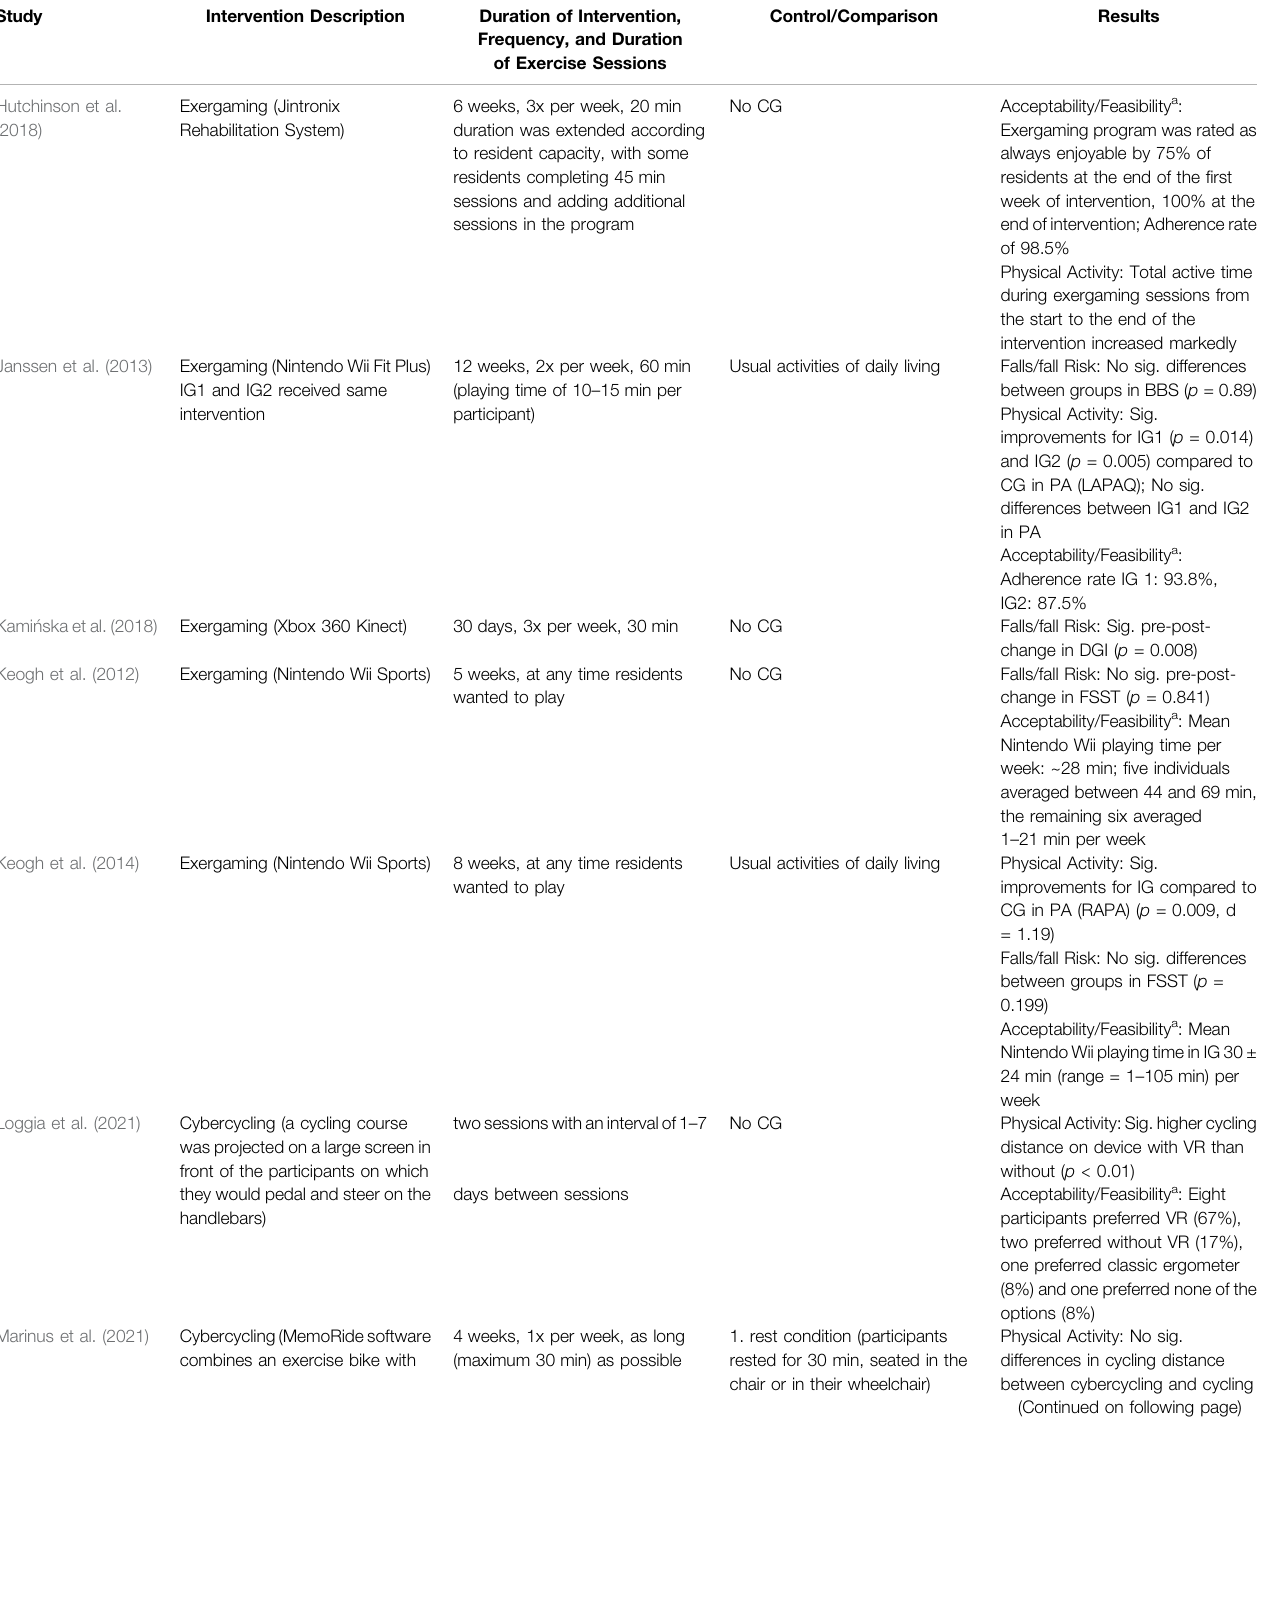
TABLE 3 | ( Continued ) Intervention/control characteristics and results of primary